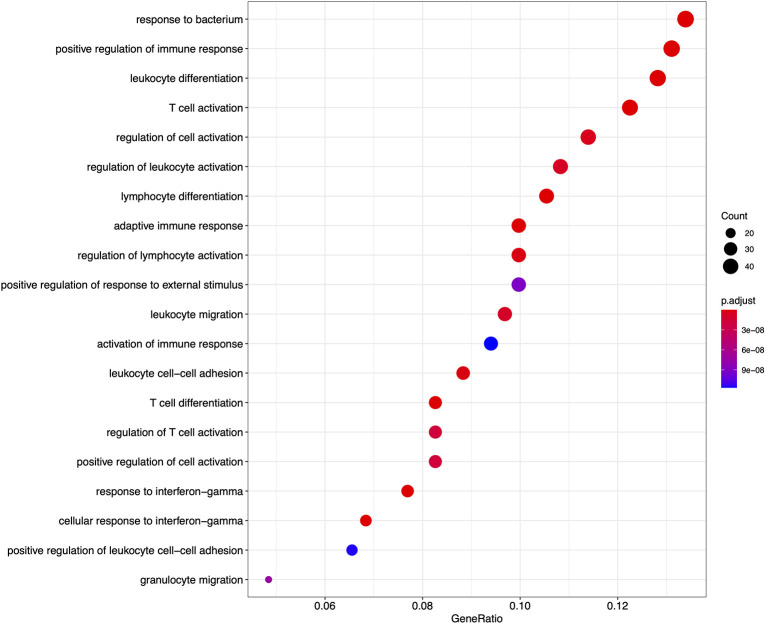
A dot plot of the top 20 most significant GO biological process ontology terms enriched among differentially expressed genes in FP. The x-axis shows the ratio of differentially expressed genes in each term relative to the total number of genes in that term. Dot size shows the number of differentially expressed genes in that term and color is the gene set enrichment analysis test statistic with Benjamini–Hochberg adjustment for multiple testing.